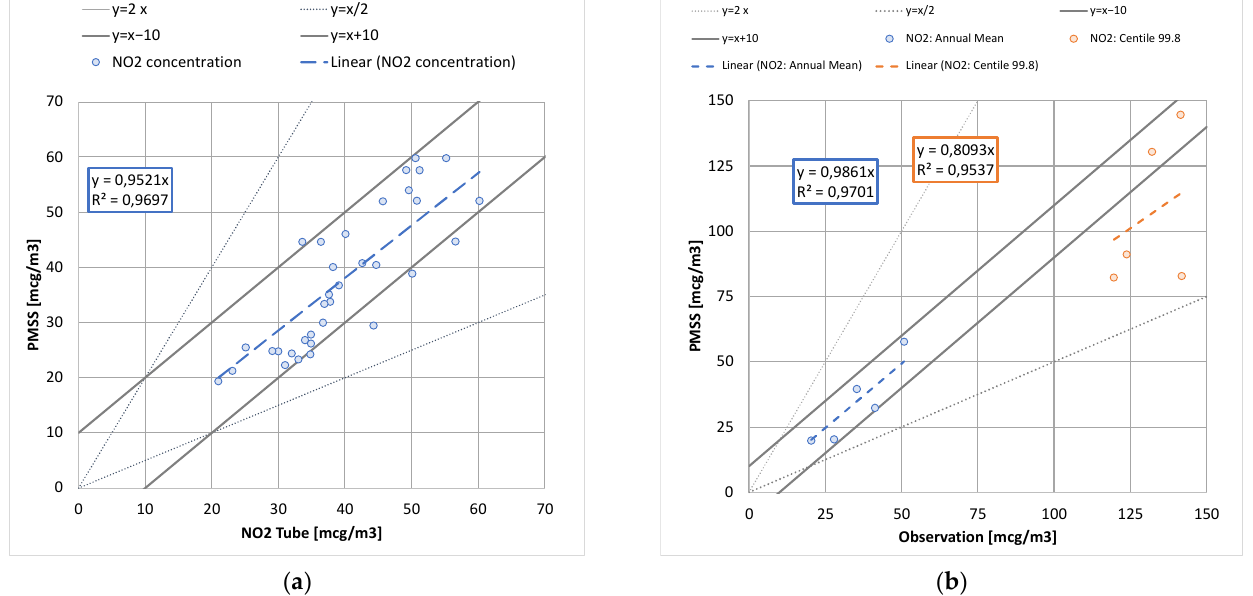
Figure 1. Comparison of observed and computed NO 2 concentration for annual average at passive sensors ( a ), and annual average and 99.8th percentile at monitoring stations ( b ).